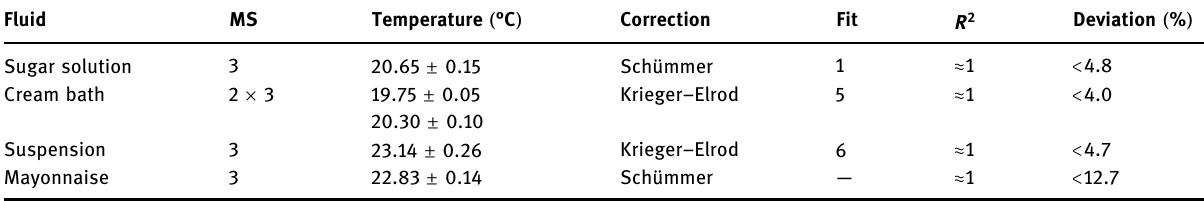
Table 1: Analysed measurement samples with associated measurement parameters and relative deviations Fluid